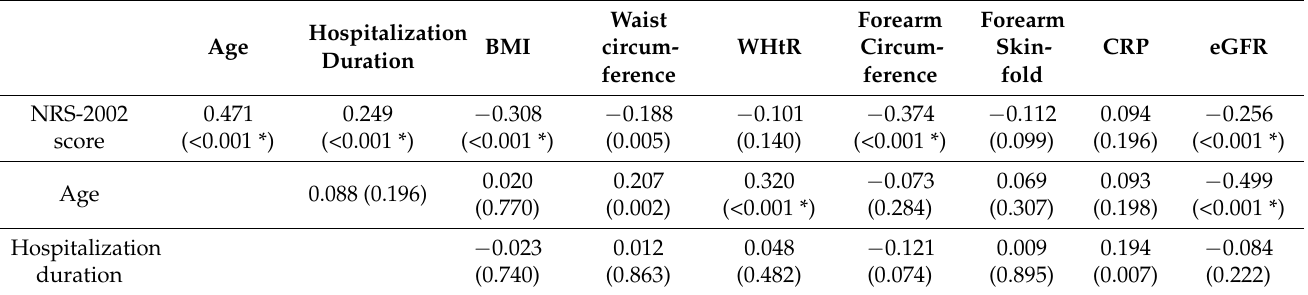
NRS-2002—Nutritional Risk Screening-2002; BMI—body mass index; WHtR—Waist-to-Height-Ratio; CRP—C reactive protein; eGFR—estimated glomerular filtration rate. Note: a Bonferroni correction was applied for the correlation analyses in this table with 24 separate p values, which sets the significance level at p < 0.002, and symbol * denotes significant results after Bonferroni correction. Predictors of re-hospitalization and death outcomes during the follow-up period are shown in Table 4. CRP concentration (OR = 1.01, 95% CI 1.00–1.02; p = 0.032),